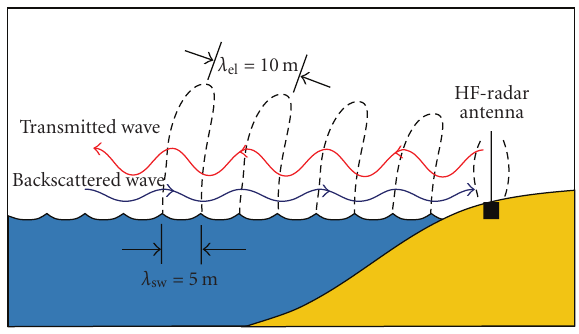
Figure 3: HF surface wave radar (IFM, University of